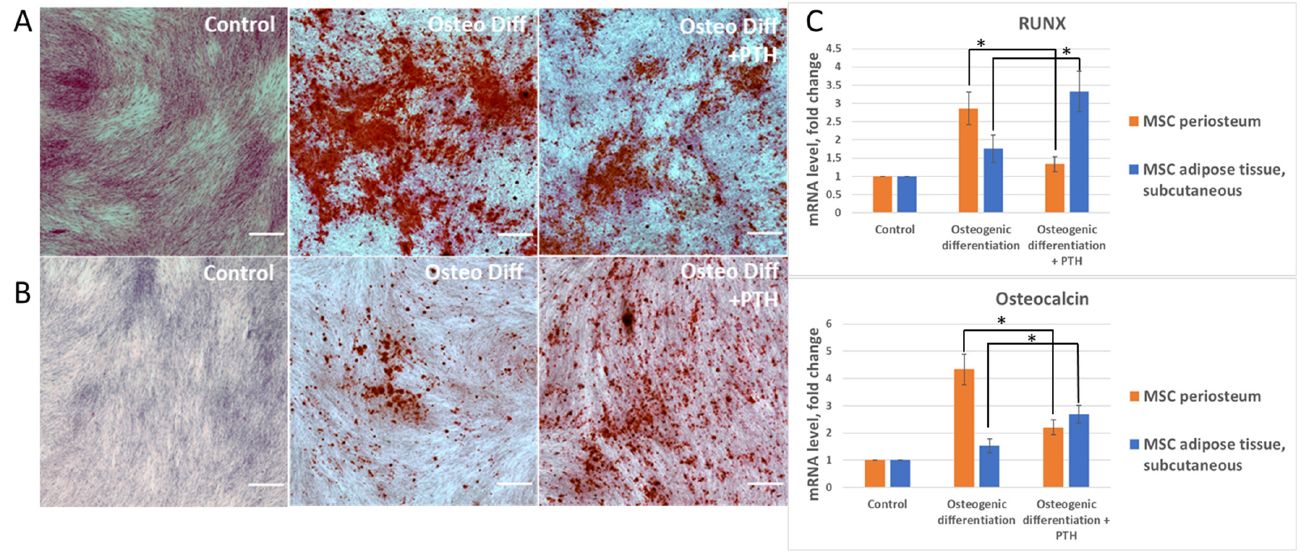
Figure 3. Periosteum MSC and adipose tissue MSC demonstrate different responses to PTH stimu- lation during osteogenesis. All presented pictures of histochemical staining were obtained on the cells from different MSC depots of the same donor. ( A , B ) Representative images of osteogenic differentiation of MSC from periosteum ( A ) and from adipose tissue ( B ) obtained from the same donor with or without stimulation by PTH. Pictures were taken after 14 days of osteogenic induction. The scale bar represents 500 µ m. ( C ) Expression of osteogenic markers in MSC on 14th day of osteo- genesis. Mean ± SE, n = 4 different donors; * p < 0.05 versus corresponding values in the “osteogenic differentiation”